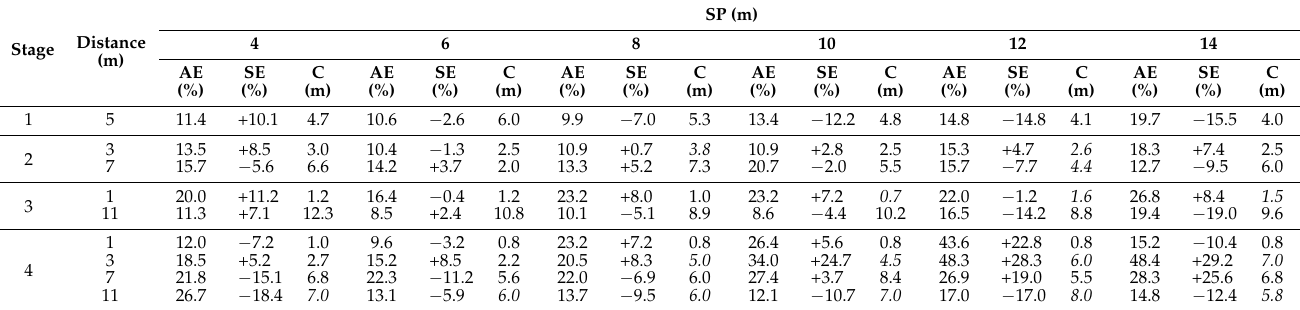
Table 2. Overview of the absolute error (AE), the signed error (SE), and the performance in the first trial in opposite swimming direction in the control session (C). Described are medium averages (%) per SP [in m from hoop station]. Each distance for each SP was tested 25 times. The algebraic signs indicated an overshooting (+) or an undershooting ( − ) of the respective distance. The final column shows the reproduction of every first trial with each distance in the control session (C). Numbers written in italics indicate the first trials of the control session within which the reproduction was outside of both